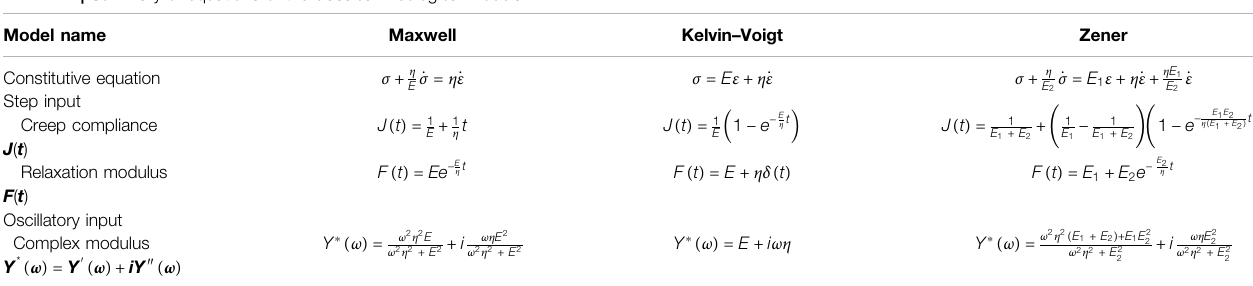
TABLE 2 | Summary of equations of the classical rheological